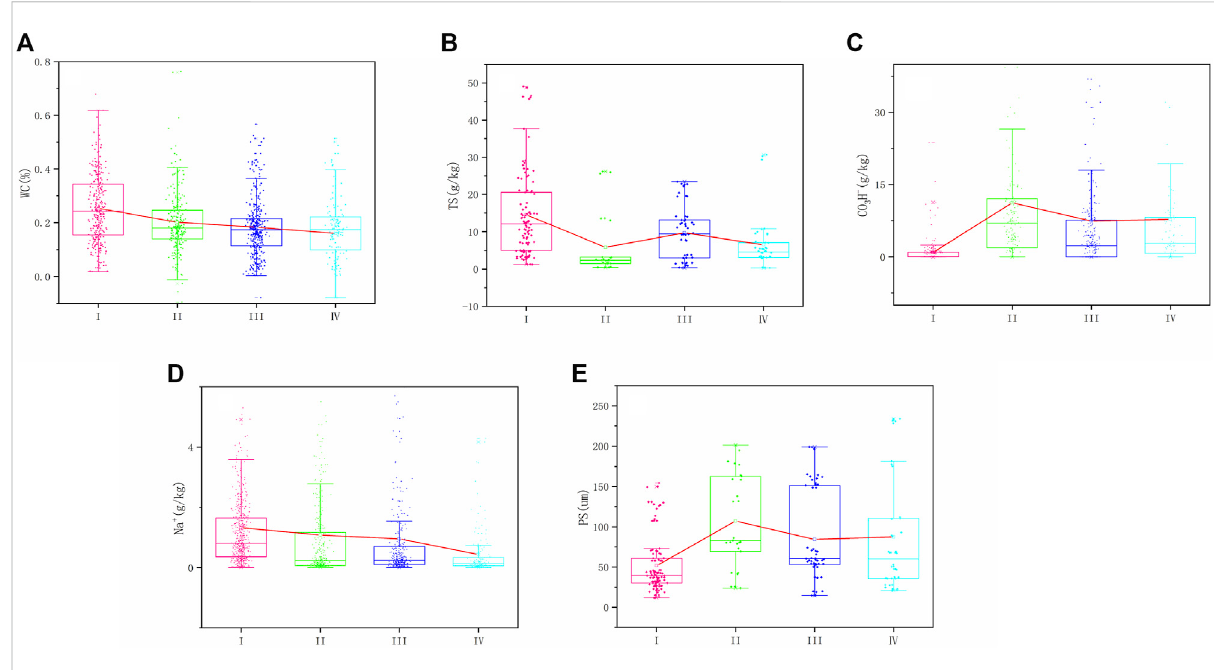
FIGURE 7 Distribution map of response thresholds of water, salinity and particle size in salt meadow soil on lake